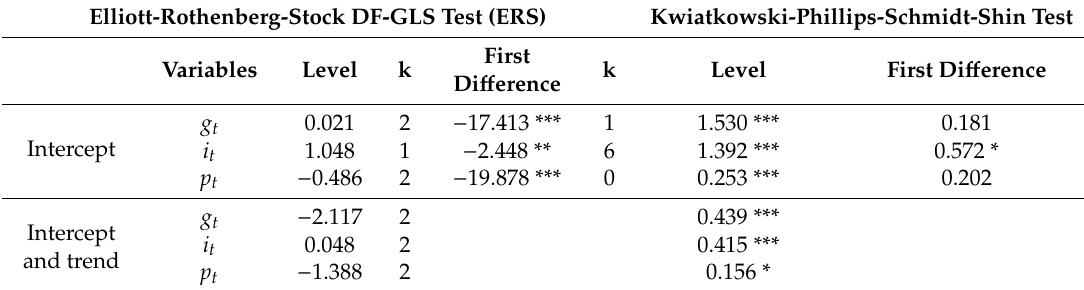
Table 2. Unit root tests’